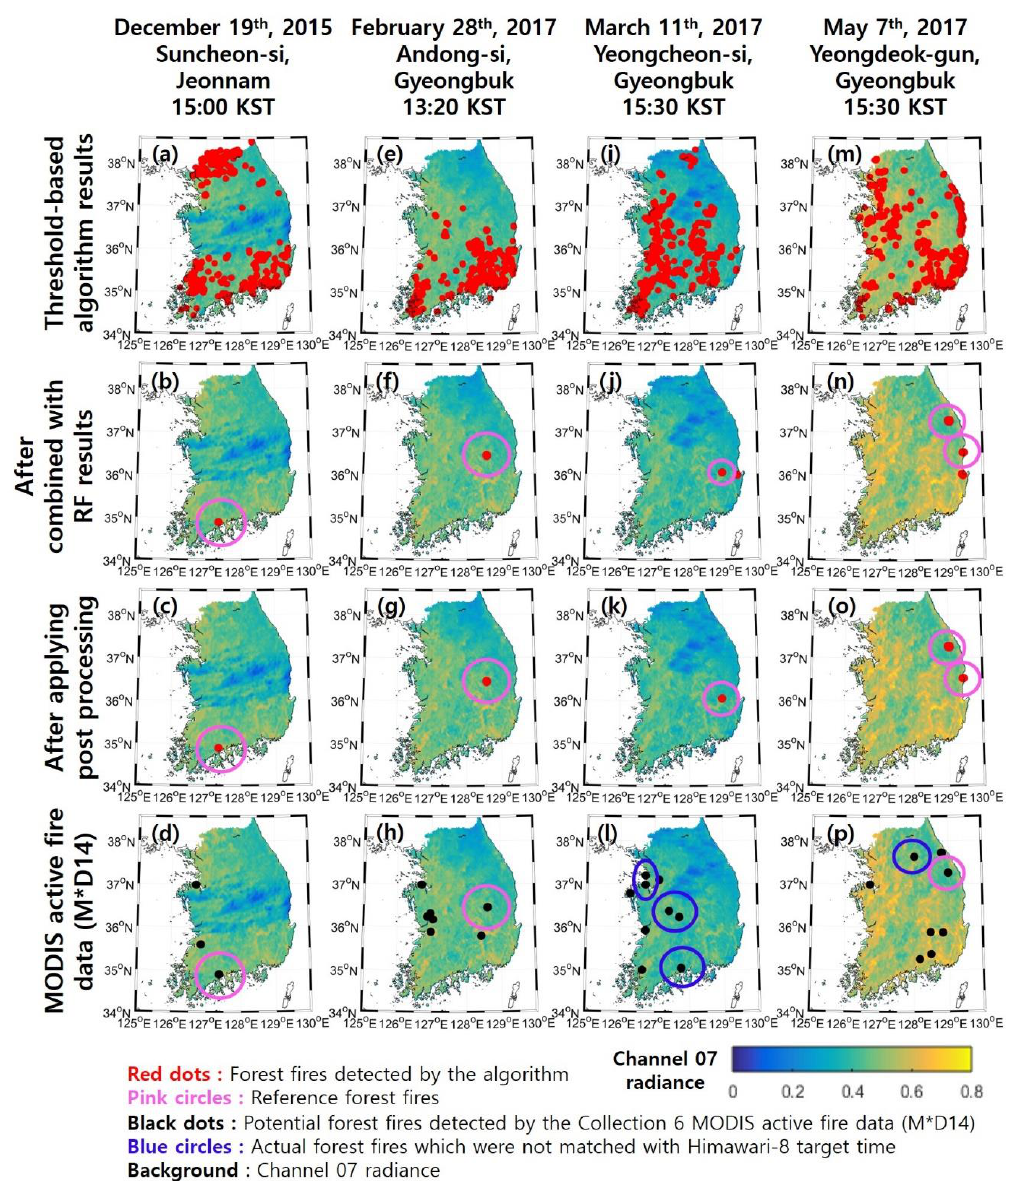
Figure 5. The maps of detected forest fires after each step: the threshold-based algorithm ( a , e , i , m ), RF modeling ( b , f , j , n ), and post processing ( c , g , k , o ) and the MODIS active fire data (M*D14; d , h , l , p ). (1) the forest fire (Suncheon-si, Jeonnam; from 13:13 to 16:00 (KST) on 19th October 2015) occurred by shaman rituals with the damaged area ~1 ha ( a , b , c , d ); (2) the forest fire (Andong-si, Gyeongbuk; from 13:10 to 15:20 (KST) on 28th February 2017) occurred due to an unknown reason with the damaged area ~0.8 ha ( e , f , g , h ); (3) forest fire (Yeongcheon-si, Gyeongbuk; from 15:13 to 18:30 (KST) on 11th March 2017) occurred due to the incineration of agricultural waste with the damaged area ~5.2 ha ( i , j , k , l ); and (4) the forest fire (upper; Gangneung-si, Gangwon; from 15:32 on 6th to 6:34 (KST) on 9th May 2017) occurred for an unknown reason with the damaged area ~252 ha and the forest fire (lower; Yeongdeok-gun, Gyeongbuk; from 14:45 on 7th to 7:00 (KST) on 8th May 2017) occurred due to a cigarette with the damaged area ~5.9 ha ( m , n , o , p ). The red dots are the potential forest fire pixels detected by the proposed algorithm, pink circles show actual forest fire cases from the reference data, black dots are the potential forest fire pixels detected by the Collection 6 MODIS active fire data, blue circles show actual forest fire cases which were not matched with Himawari-8 target time, and the band 7 radiance of Himawari-8 AHI of each image is used as a background image. These five forest fire cases of four dates come from the validation data, which were not used in training of the RF